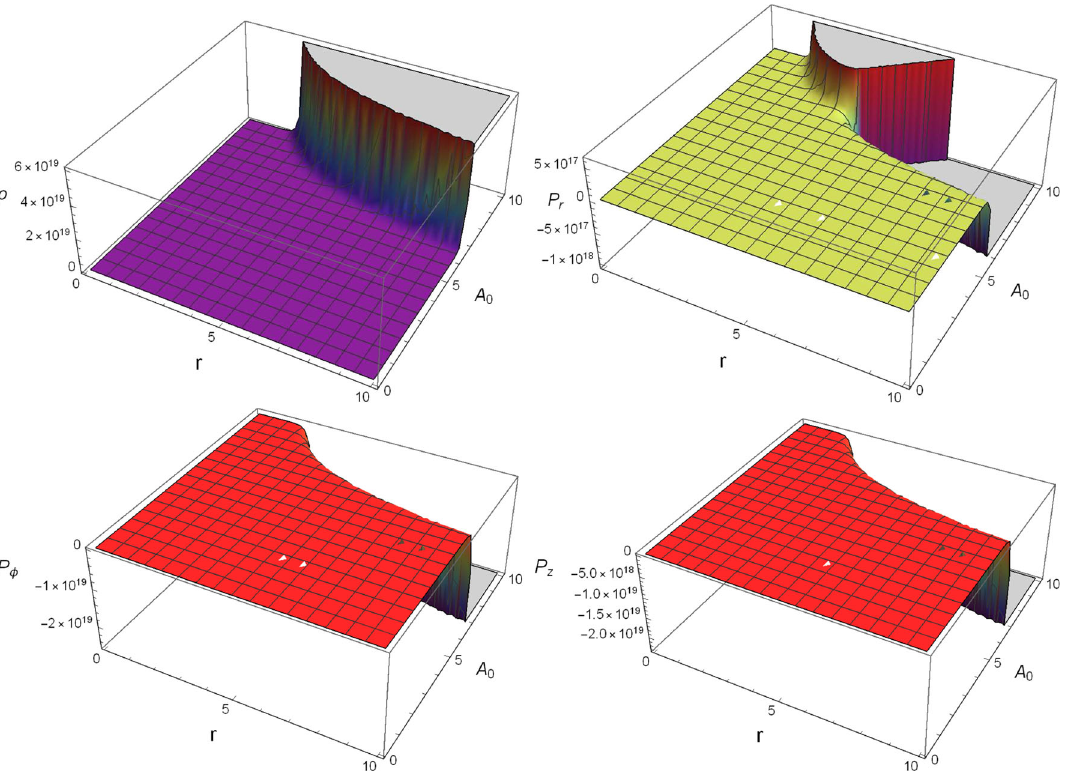
Fig. 29 This panel shows the graphical behavior of energy density (MeV/fm 3 ) which is positive w.r.t radial coordinate. Whereas, the graphical behavior of P r (MeV/fm 3 ) , P φ (MeV/fm 3 ) and P z (MeV/fm 3 ) is negative w.r.t radial coordinate